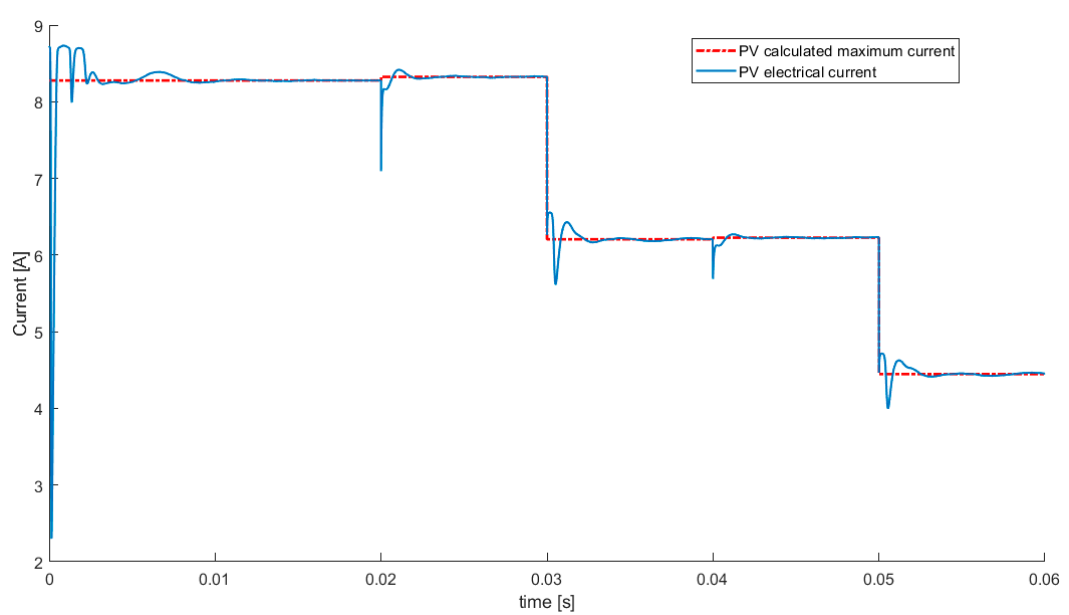
Figure 11. Evolution of PV current over time.